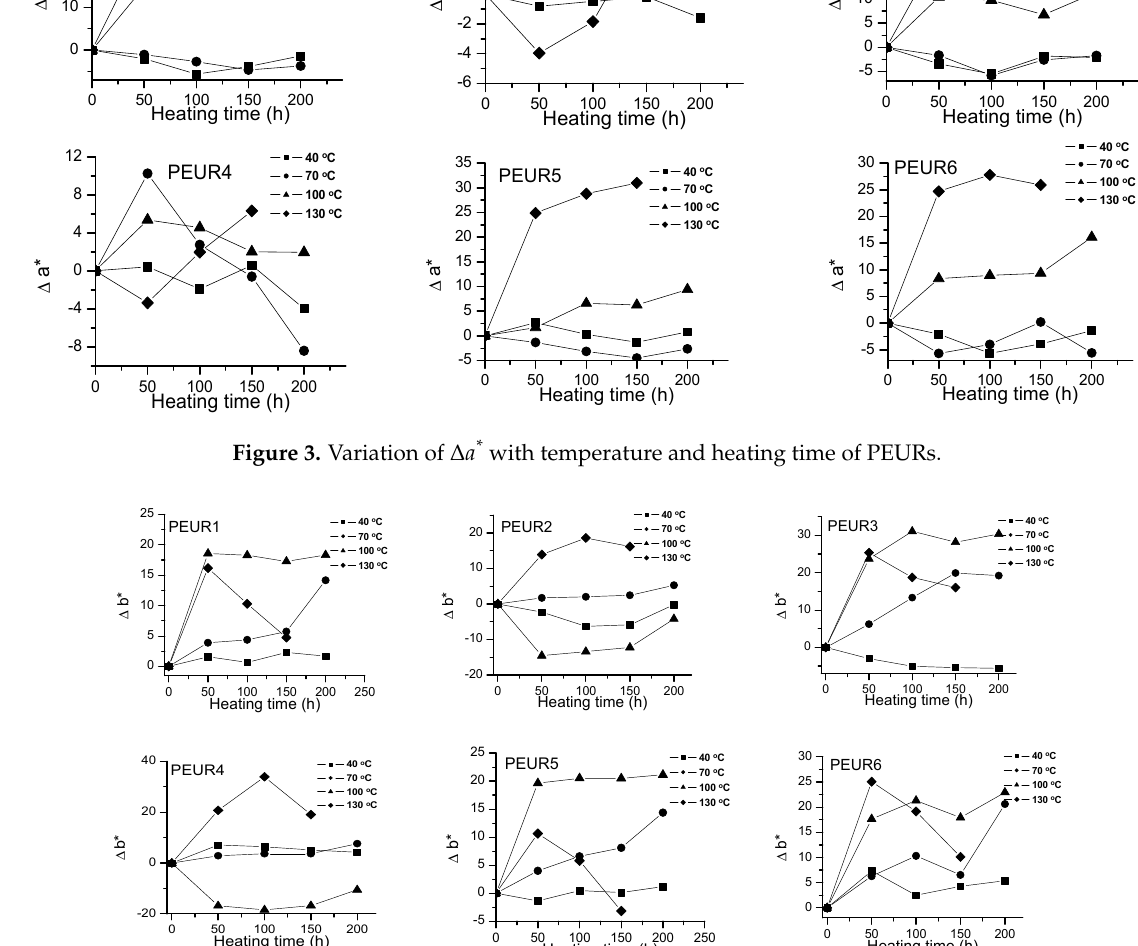
Figure 2. Variation of Δ L * with temperature and heating time of PEURs. The negative Δ L * values indicate surface darkening during the thermal treatment of the PEURs. For PEURs 1, 2, 3, 5 and 6 treated at 40 and 70 °C, a slight discoloring may be observed through minor increases in Δ L * values. For PEUR4, up to 150 h and at 40, 70 and 100 °C, Δ L * values are positive. At over 150 h of thermal aging at 100 and 130 °C the Δ L * values become negative, hence the samples darken. For the thermal treatments of PEURs 1, 2, 3, 5 and 6 at 100 and 130 °C the Δ L * values also become negative. For sample PEUR3 at 100 °C a strong discoloration may be observed in the first 50 h. PEUR1 darkens at temperature values below 100 °C and at lower temperatures and it lightens after 100 h. For the thermal treatment at 40 °C, Δ L * values of PEUR1 vary very little with time. At 40 and 70 °C PEUR2 shows minor modifications of Δ L * up to 150 h, after which it lightens, Δ L * strongly increasing. For thermal treatments at 130 °C PEUR2 slowly darkens up to 150 h, after which it strongly lightens. Red and yellow degradation intermediates accumulate on the surface of samples during the thermal treatment, as it can be seen from Figure 3, Figure 4 and Table 2. The displacements of ∆ a * and ∆ b * to either positive or negative values do not show any pattern. This is an indication of the formation of highly instable colored intermediates during thermal aging. PEUR2